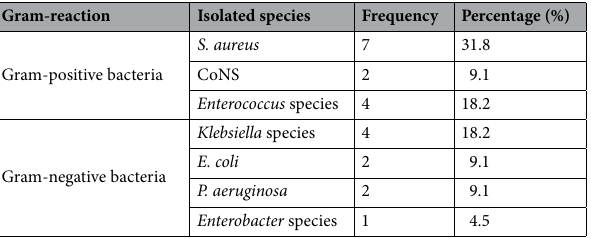
Table 2. Bacterial isolates of blood culture among patients attending at AMGH, southern Ethiopia, 2021.